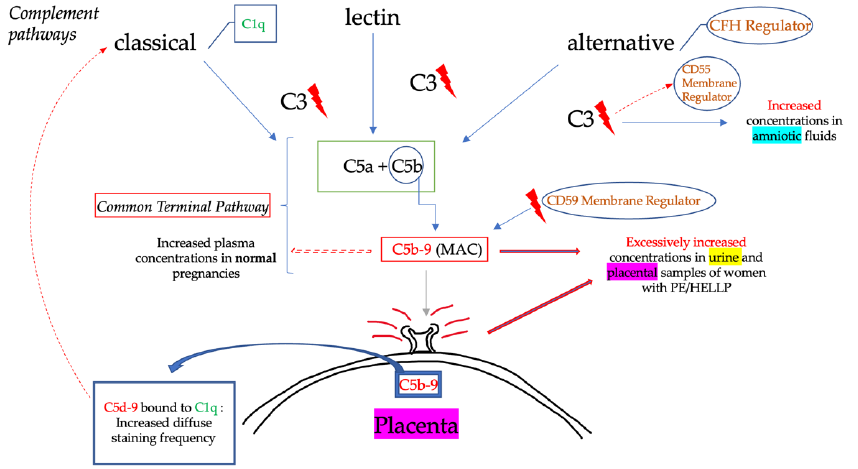
Figure 1. Complement cascade dysregulation in preeclampsia and HELLP syndrome. (CFH, Com- plement Factor H; C1q, C3, Complement proteins; CD55, CD59, Complement Regulators; C5a, C5b, Complement proteins /Anaphylatoxins; MAC, Membrane Attack Complex).